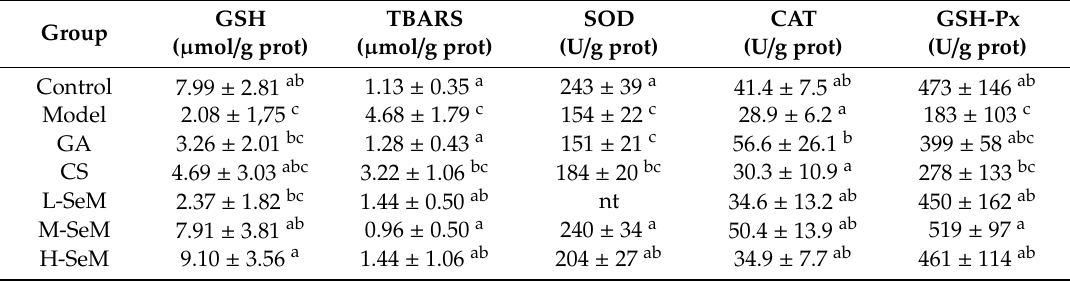
Table 5. The levels of GSH, thiobarbituric acid-reactive substances (TBARS), superoxide dismutase (SOD), catalase (CAT), and glutathione peroxidase (GSH-Px) in mice liver ( n = 10). GSH TBARS SOD CAT GSH-Px Group ( µ mol / g prot) ( µ mol / g prot) (U / g prot) (U / g prot) (U / g prot) Control 7.99 ± 2.81 ab 1.13 ± 0.35 a 243 ± 39 a 41.4 ± 7.5 ab 473 ± 146 ab Model 2.08 ± 1,75 c 4.68 ± 1.79 c 154 ± 22 c 28.9 ± 6.2 a 183 ± 103 c GA 3.26 ± 2.01 bc 1.28 ± 0.43 a 151 ± 21 c 56.6 ± 26.1 b CS 4.69 ± 3.03 abc 3.22 ± 1.06 bc 184 ± 20 bc L-SeM 2.37 ± 1.82 bc 1.44 ± 0.50 ab nt 34.6 ± 13.2 ab M-SeM 7.91 ± 3.81